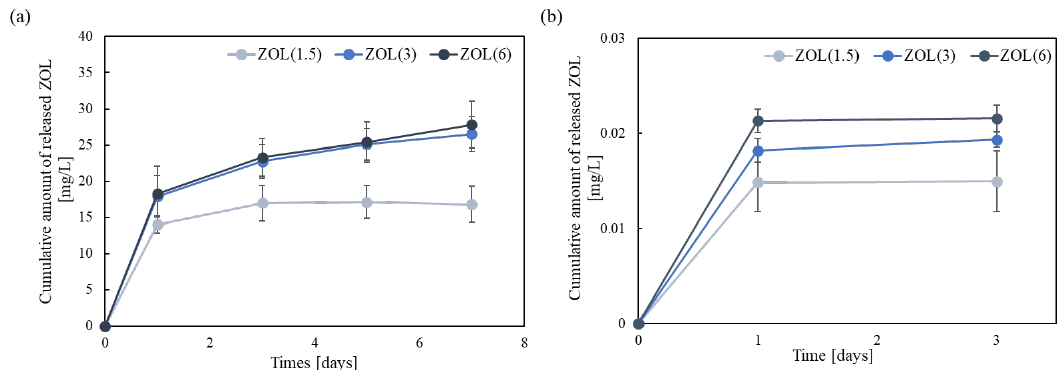
Figure 3. Cumulative amount of released ZOL from ZOL/β-TCP. Cumulative amount of released ZOL from ( a ) ZOL/β-TCP powders and ( b ) ZOL/β-TCP disc in Tris-HCl buffer (pH 7.3). Error bars indicate standard deviation of the mean.